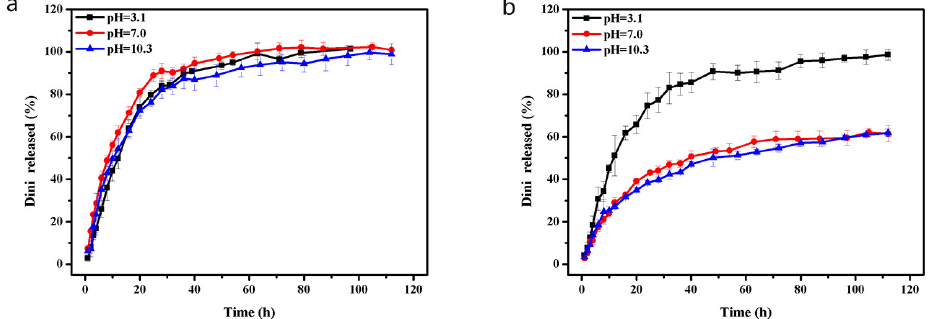
Figure 7. The curves of Dini release from Dini@NH 2 -Fe-MIL-101 ( a ) and PDA@Dini@NH 2 -Fe-MIL-101 ( b ) at different pH values of 3.1, 7.0 and 10.3. Error bars correspond to standard errors of triplicate measurements.